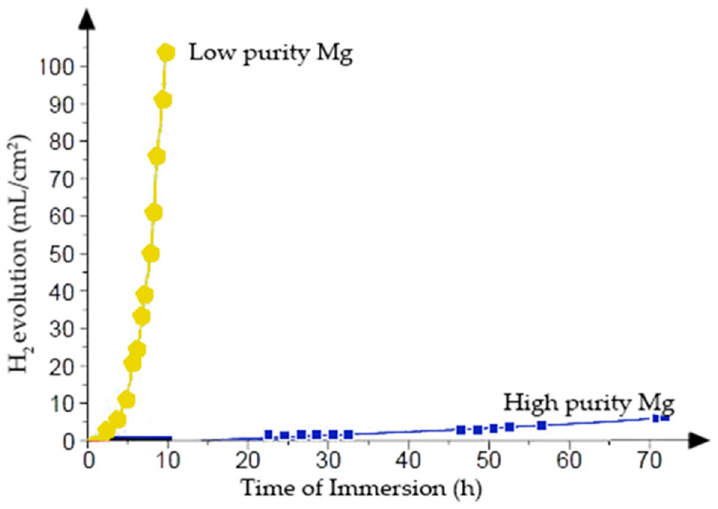
Figure 2. High purity Mg vs. low purity Mg corrosion rates.